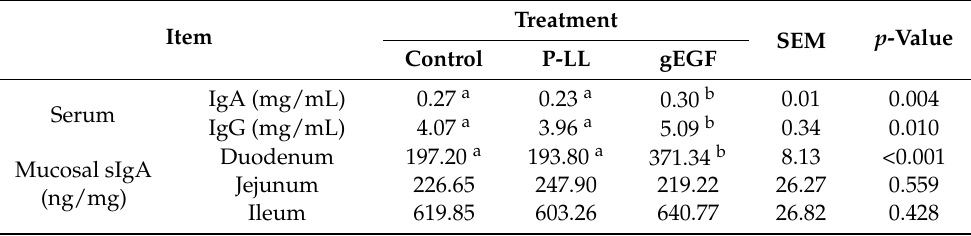
Table 4. Effects of gEGF on serum and mucosal immunoglobulins of treated broilers in two weeks of treatment. SEM: Standard Error of Mean. Data represented mean of 3 replications per treatment with 3 broilers per replication ( n = 3). Means within a row without superscripts (a or b) were of no significant difference ( p > 0.05). Means within a row with different superscripts (a or b) differed significantly ( p <